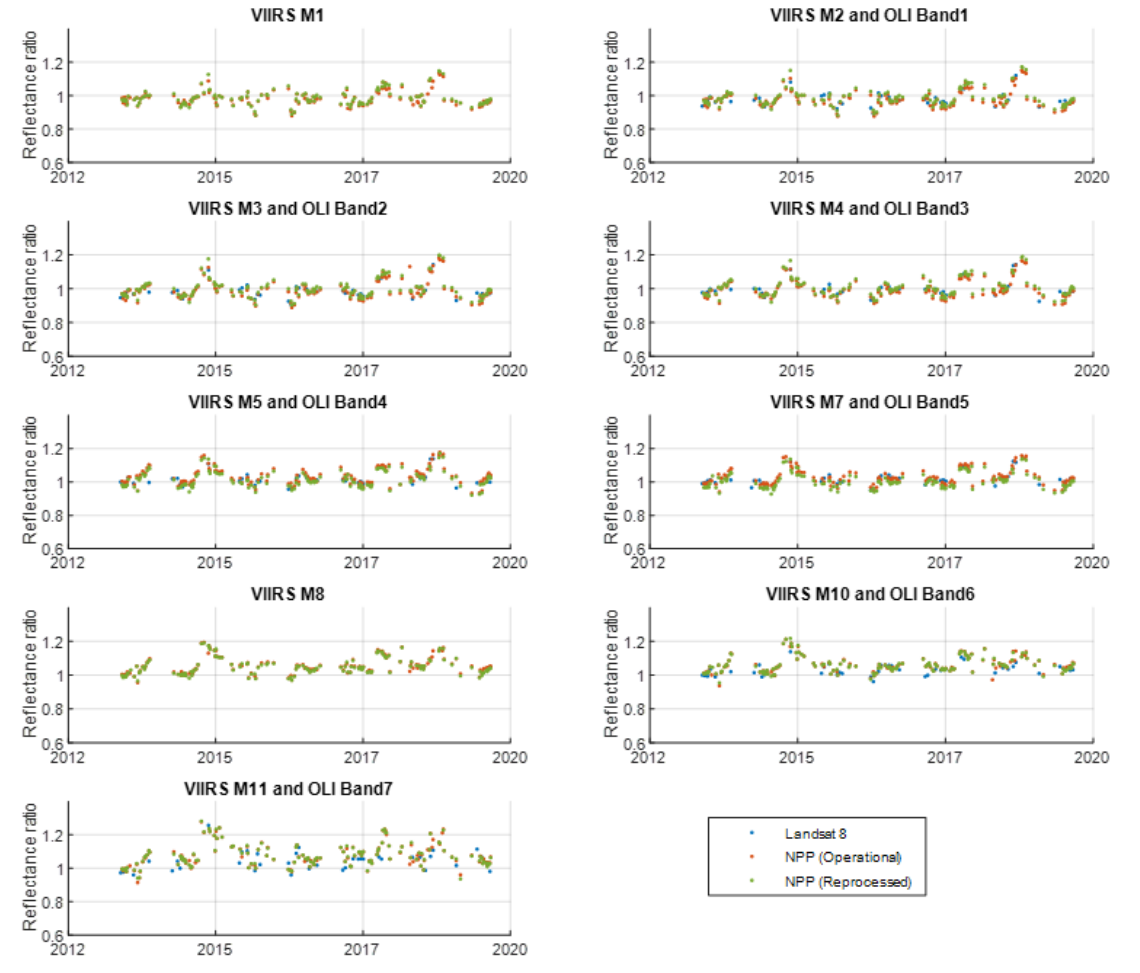
Figure 7. The time series of the reflectance ratio between RadCalNet with Landsat-8/OLI, opera- tional SNPP/VIIRS, and reprocessed SNPP/VIIRS over RVUS from May 2013 to August 2019. SNPP/VIIRS, and reprocessed SNPP/VIIRS over RVUS from May 2013 to August